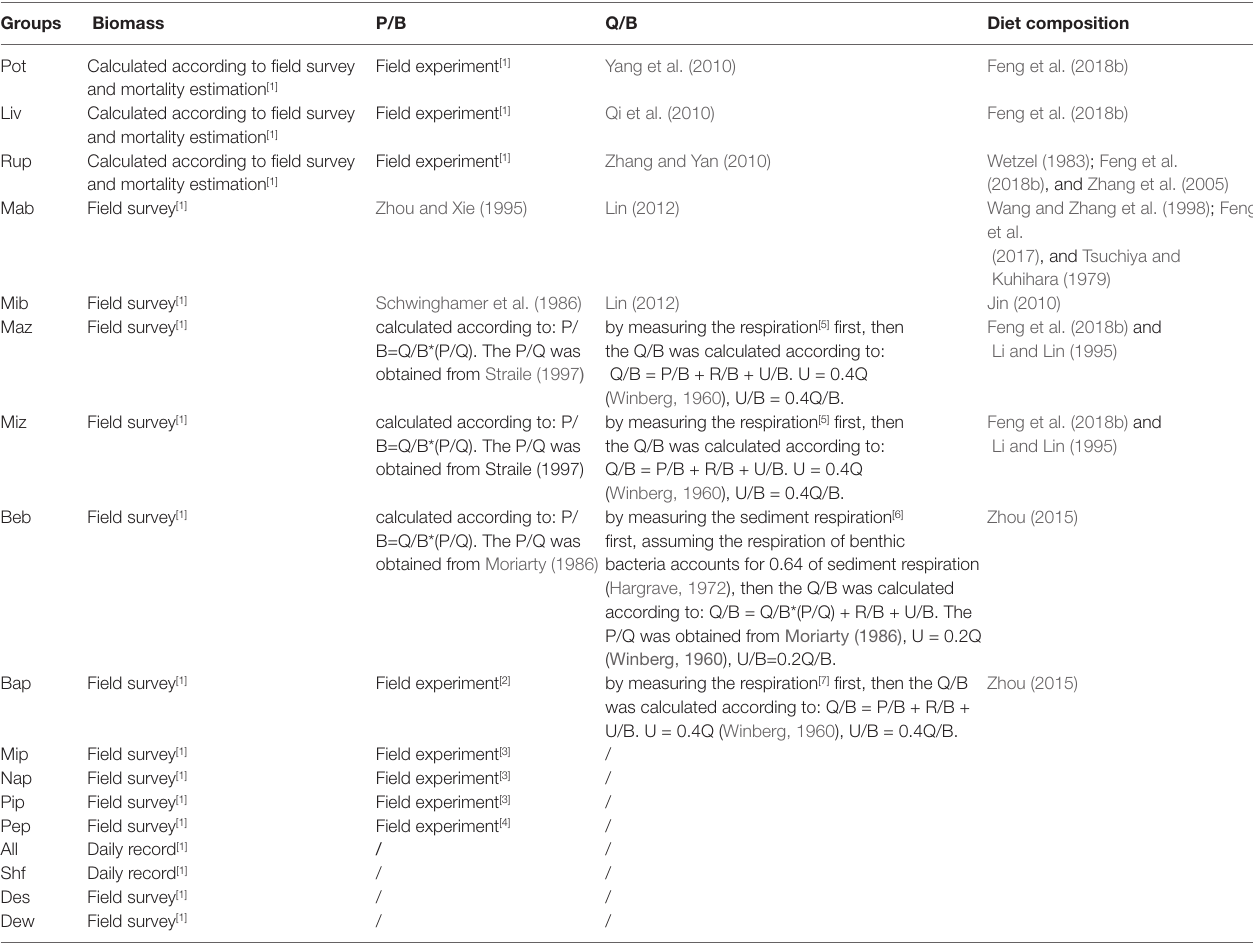
TABLE 2 | Data sources of B, P/B, Q/B, and diet composition of each group in the Portunus trituberculatus polyculture